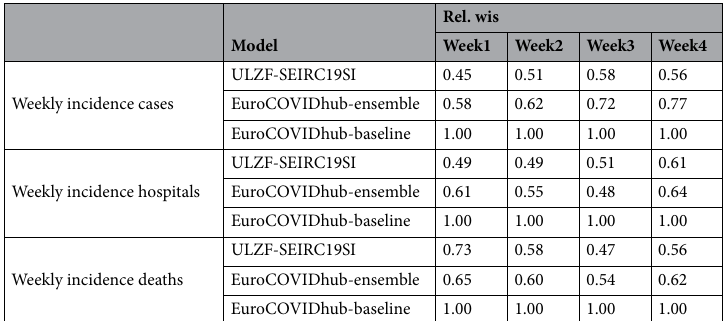
Table 3. Performances of the 3 models within European Covid-19 Forecast Hub project on the Slovenian data from January 1, 2022 to March 28, 2022, measured by the relative weighted interval score (rel.wis).